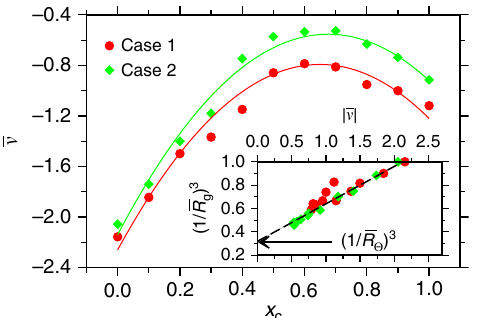
Fig. 4 Variation in monomer excluded volume with changing solvent – cosolvent mixing ratios. Normalized excluded volume V ¼ V = V m as a function of cosolvent mole fraction x c . The results are shown for two cases. Lines are fi ts to the data corresponding to Eq. (1). In the inset, we (cid:7) (cid:8) 3 as a function of normalized V . Here, R present 1 = R g the normalized gyration radius R g . The line is a fi t based on Eq. (5)